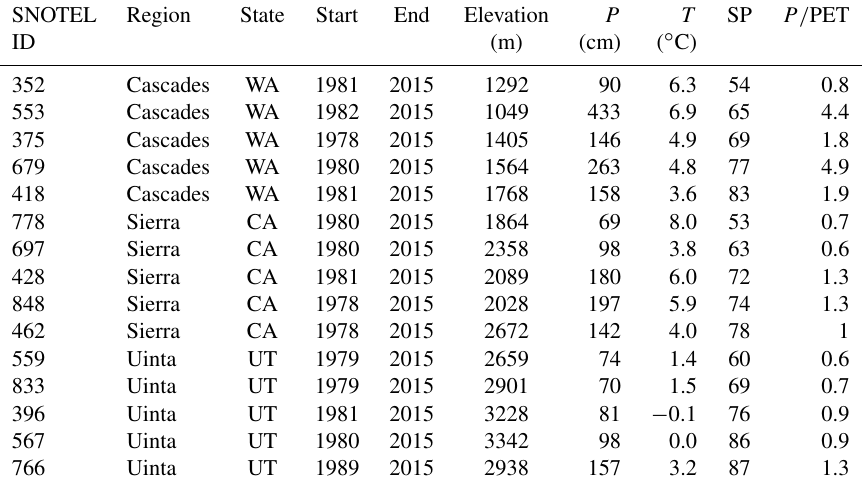
Table 1. SNOTEL station properties including the start and end of data records, site elevation, and mean annual climatic characteristics: precipitation ( P ), temperature ( T ), snow persistence (SP, %), and aridity index ( P/ PET).